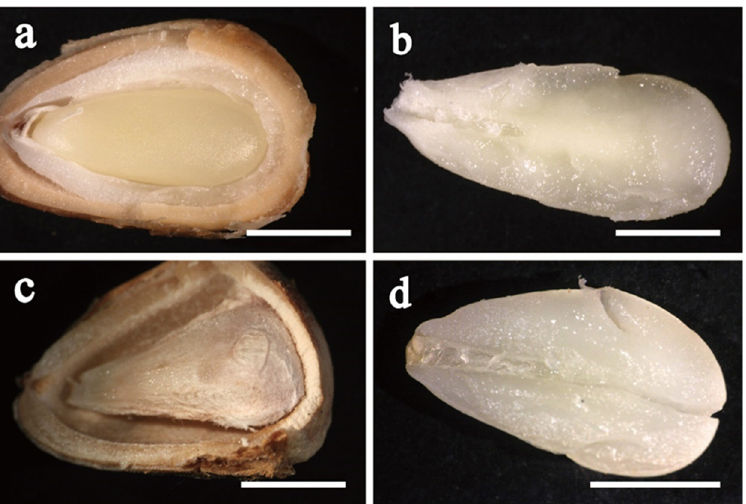
Figure 2. State of kernels and explants of immature seeds of Korean pine before and after 4 °C preservation. ( a ) The state of immature seeds preserved at 4 °C for 0 days. Scale = 1 cm. ( b ) The development status of immature ZEs preserved at 4 °C for 0 day. Scale = 0.6 cm. ( c ) The state of immature seeds preserved at 4 °C for 28 days. Scale = 1 cm. ( d ) The developmental state of immature ZEs preserved at 4 °C for 28 days. Scale = 0.6 cm.